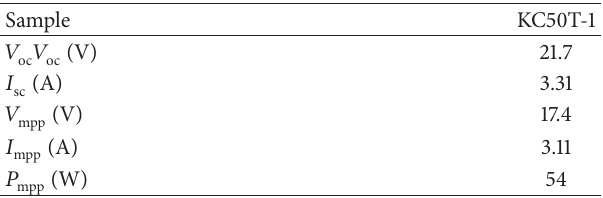
Table 1: Main parameters of the PV module used in shading model verification experiments (STC).